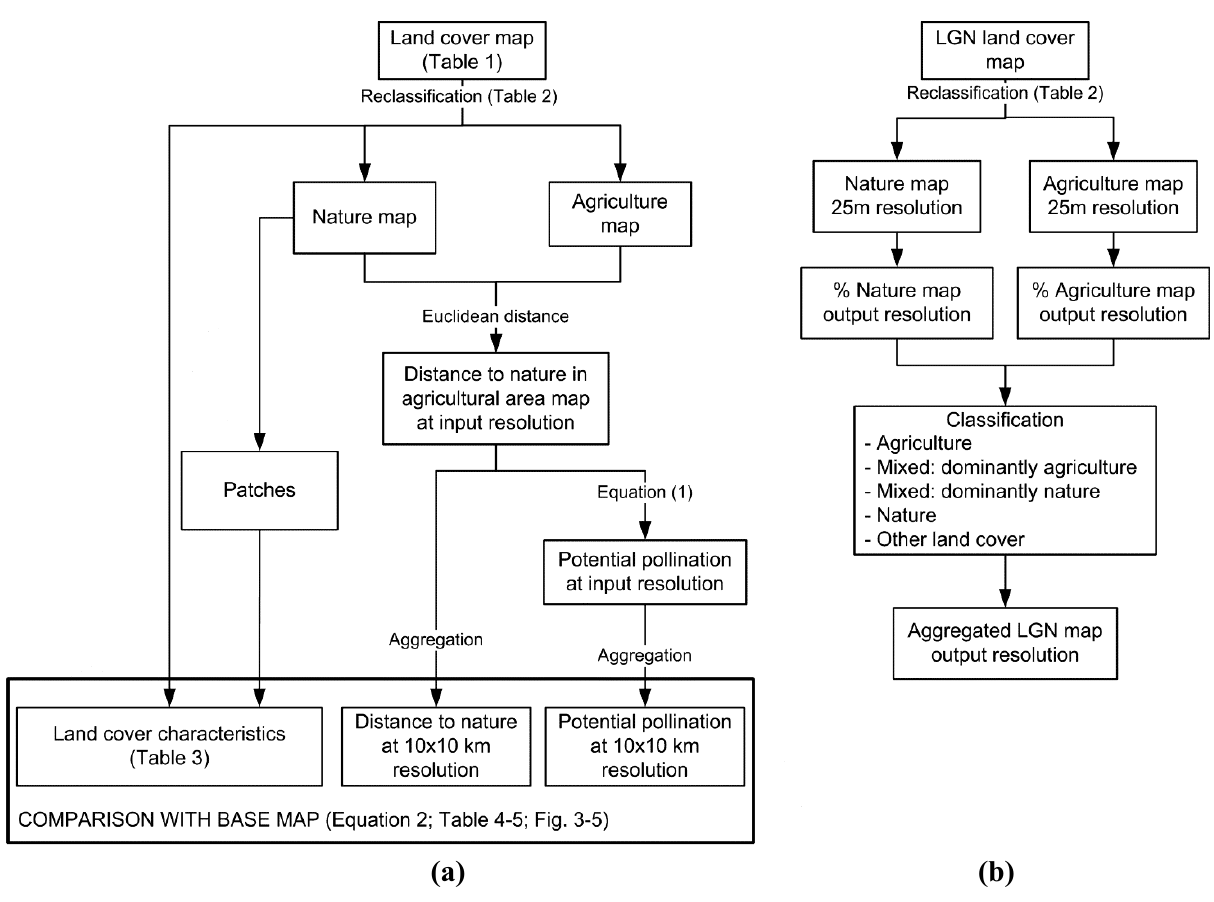
Figure 1. ( a ) Flowchart of the analyses; and ( b ) Procedure for aggregating the 25-m resolution Land Use Map of the Netherlands